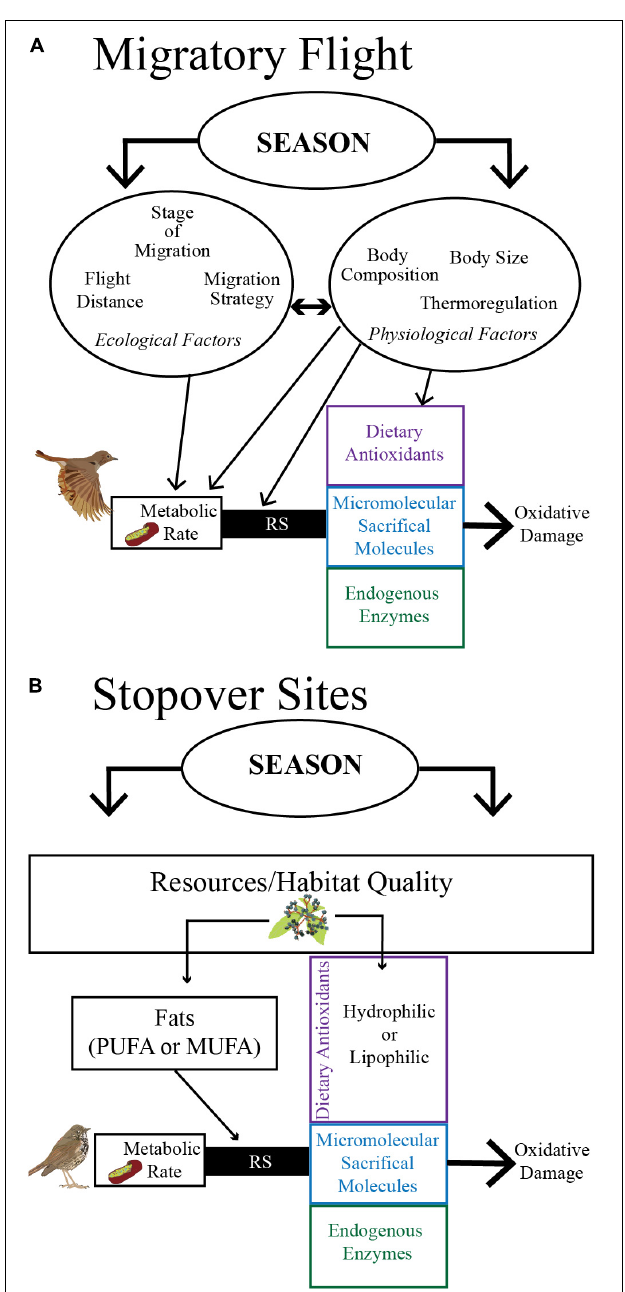
FIGURE 1 | During migration, a multitude of ecological and physiological factors that may be different between seasons (fall vs. spring migration) can alter a bird’s metabolic rate and subsequent reactive species (RS) production, as well as how the multifaceted antioxidant system responds to RS production during endurance flight (A) and during recovery from flight and preparations for the next flight while at a stopover site (B) . The multifaceted antioxidant system consists of ingested dietary antioxidants, micromolecular sacrificial molecules (e.g., uric acid, a byproduct of protein catabolism), and endogenous enzymes that may respond to the production of RS produced primarily in mitochondria. Here, we layout some examples that likely underly observed variation in measurements of oxidative status during migratory flight and stopover. (A) The increase in metabolic rate during flight is influenced